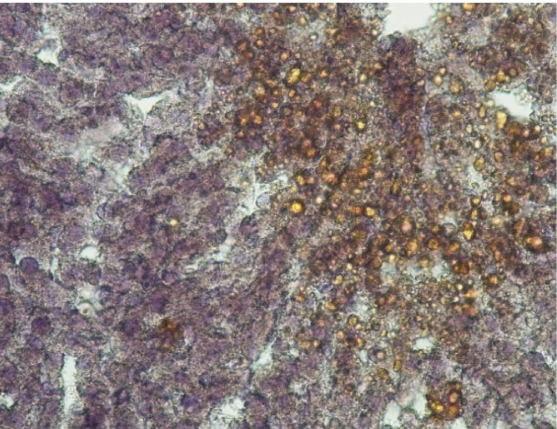
Figure 3. Lipid-containing vacuoles in the hepatocytes. EtOH + CL. Sudan-III staining with hema- toxylin afterstain, × 200.